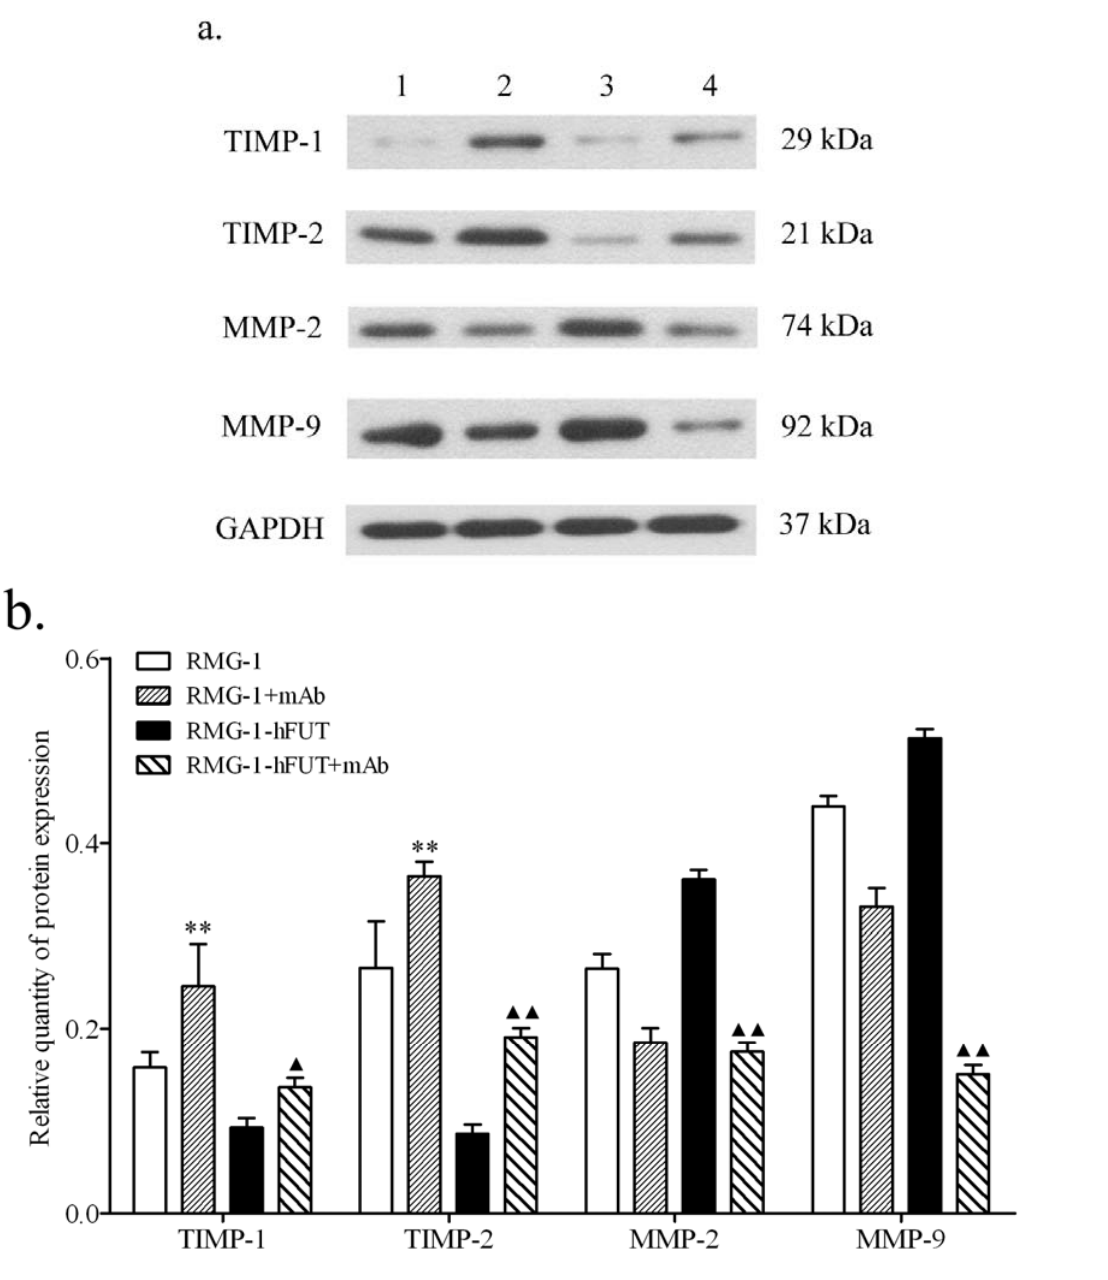
Figure 4. Protein levels of MMP-2, MMP-9, TIMP-1 and TIMP-2 in RMG-1 and RMG-1-hFUT cells treated with anti-Lewis (y) antibody. ( a ) A representative Western blot of three independent and reproducible experiments. Lane 1. RMG-1 cells; 2. RMG-1 cells + antibody; 3. RMG-1-hFUT cells; 4. RMG-1-hFUT cells + antibody. ( b ) Quantitative data were expressed as the intensity ratio target genes to GAPDH. * vs. RMG-1